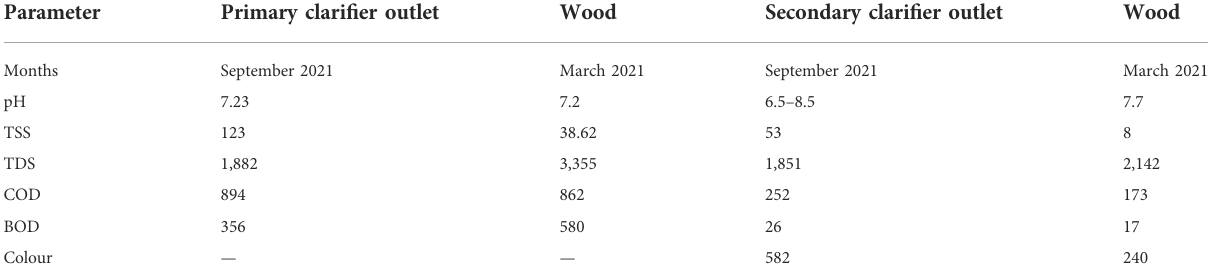
TABLE 7 Wastewater treatment of paper and pulp